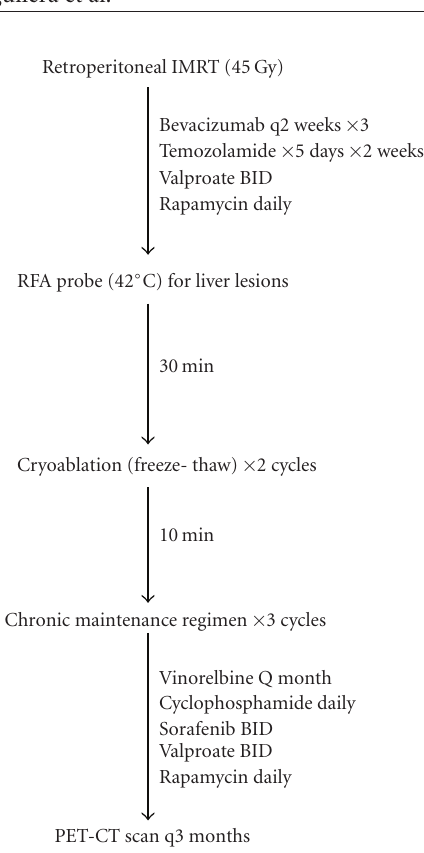
Figure 6: Schema for local control of relapse foci and continuation adjuvant therapy . Radiation in combination with bevacizumab was used to pericaval disease. Localized perihepatic lesions were treated with a combination of RFA and cryoablation. These measures were followed with a chronic adjuvant